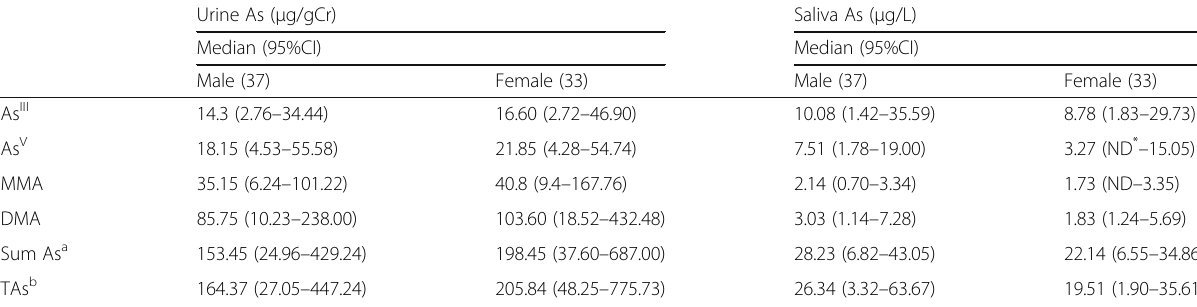
Table 3 Concentrations of different arsenic species, Sum As and total arsenic (TAs) in urine and saliva samples